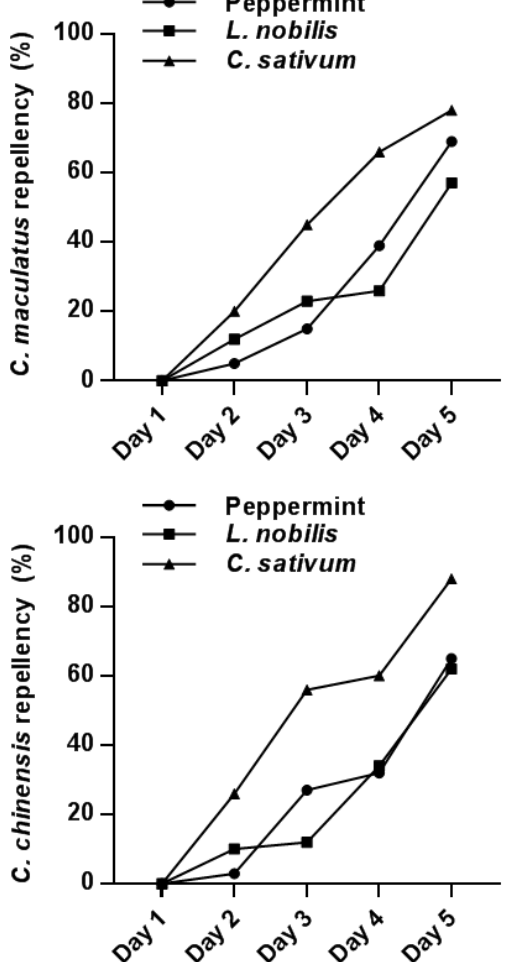
Figure 2. The repellent effect of M. piperita , L. nobilis , and C. sativum essential oils Nano granules on C. maculatus and C.